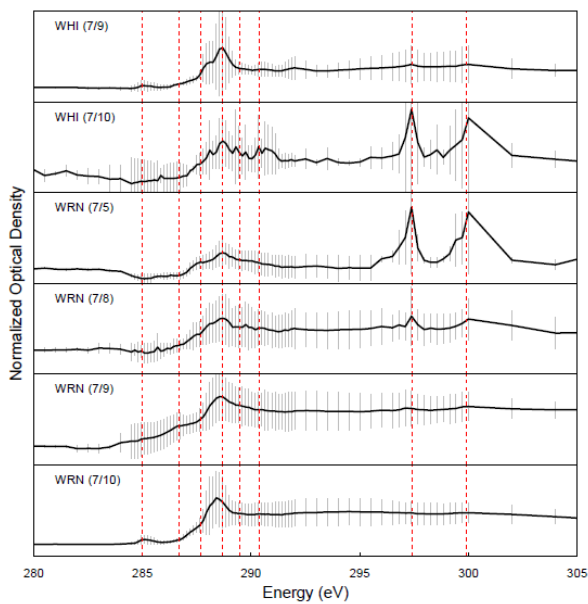
1068 1069 Fig. 6. The black solid lines represent the average of spectra of the 1070 Fig. 6. The black solid lines represent the average of spectra of the particles from a specific 1071 particles from a specific sample. Gray vertical lines represent the sample. Grey vertical lines represent the standard deviation. Red dotted lines show the 1072 standard deviation. Red dotted lines show the locations of the func- locations of the functional groups: 285 eV for alkene, 286.7 eV for ketonic carbonyl, 287.7 1073 eV for alkyl, 288.7 eV for carboxylic carbonyl, 289.5 eV for alcohol, 290.4 eV for carbonate, 1074 tional groups: 285eV for alkene, 286.7eV for ketonic carbonyl, and 297.4 and 299.9 eV for K absorptions. 1075 287.7eV for alkyl, 288.7eV for carboxylic carbonyl, 289.5eV for alcohol, 290.4eV for carbonate, and 297.4 and 299.9eV for K ab- sorptions.